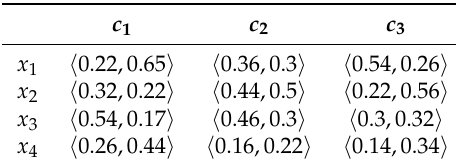
Table 1. R 1 : opinion of expert m